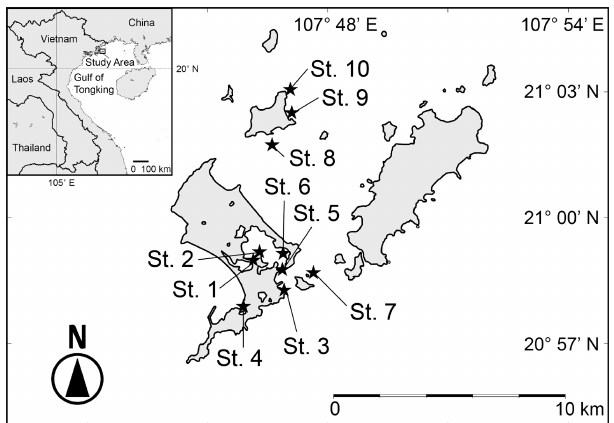
Figure 1. Map of the study area in the Co To Islands, indicating sampling sites (black filled stars); inset shows the location of the study area on the northeastern coast of Vietnam. The numbers of each station correspond to those in Table